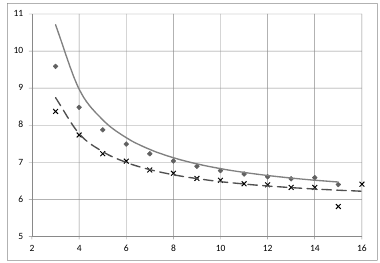
Figure 1. Ratios of the errors in cases α = 3 / 2 (W) and α = 1 / 2 ( × ) and theoretical ratios if the convergence rate was CN − β r N for β = 3 / 2 (continuous line) and β = 1 (dashed